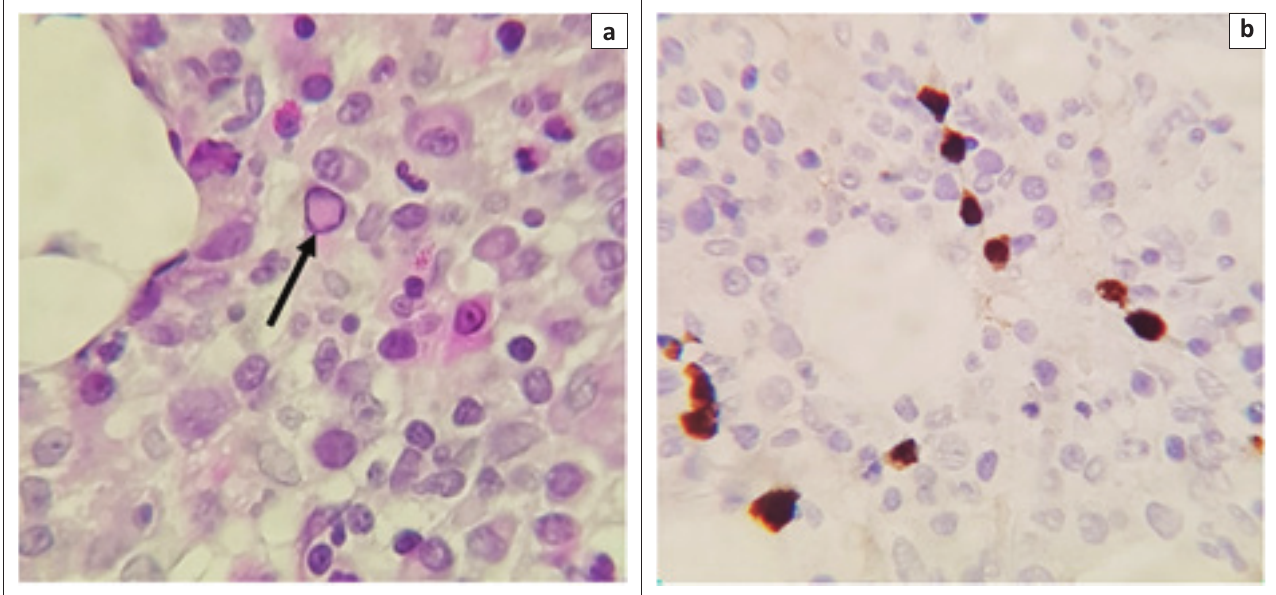
FIGURE 4: Bone marrow trephine biopsy showing parvovirus B-19 Inclusions. (a) Occasional parvovirus inclusions were seen (black arrow, haematoxylin and eosin, 500× magnification). (b) Parvovirus immunohistochemical stain positive (brown intranuclear staining, 400× magnification).